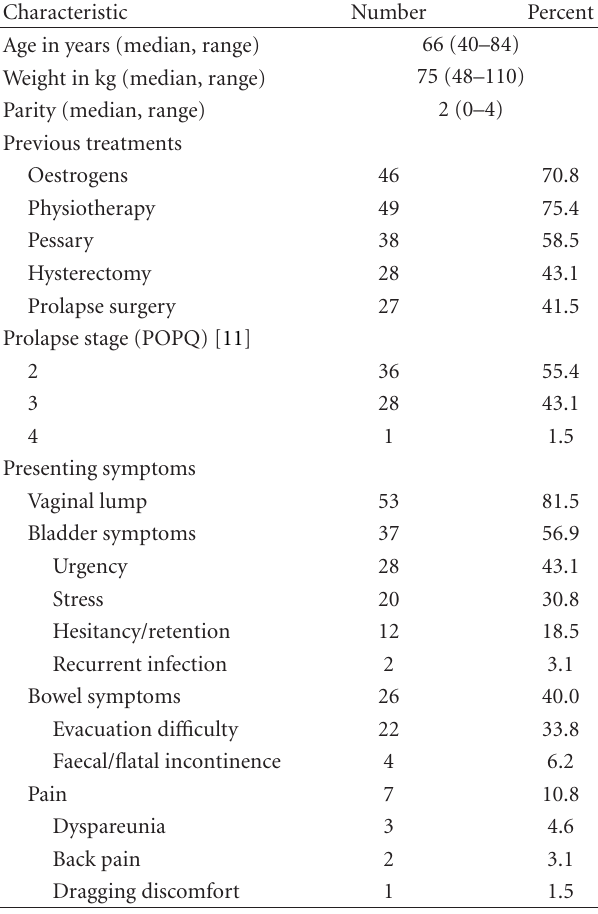
Table 1: Patient characteristics and preoperative assessments.